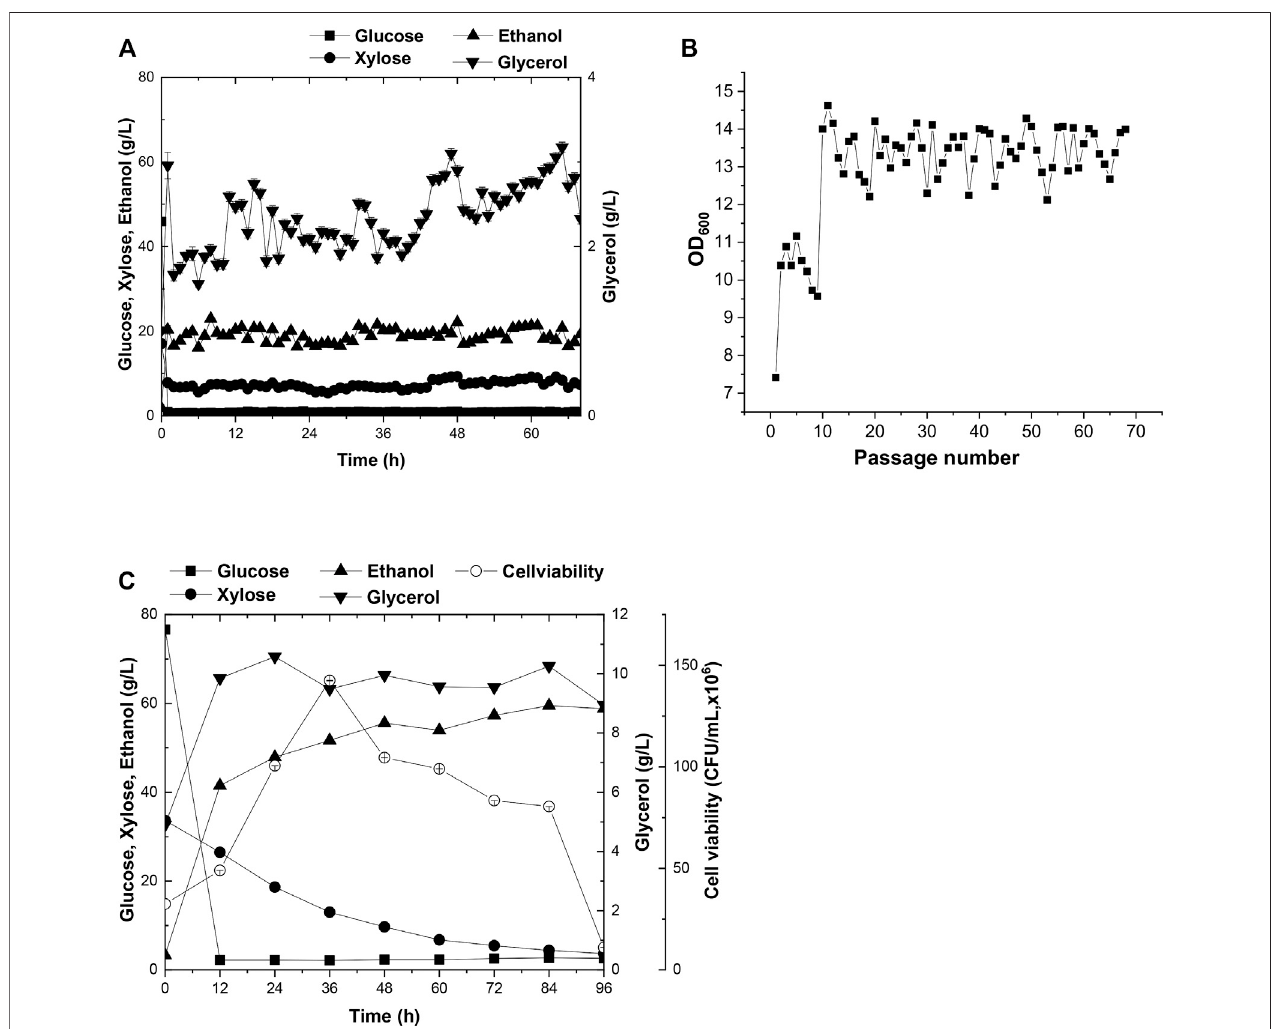
FIGURE 3 | Time-dependent fermentation of A21Z and A31Z. Fermentation pro fi le of A21Z in treated wheat straw hydrolysate with 45.85 g/L glucose, 17.07 g/L xylose, 1.84 g/L ethanol, and 1.01 g/L glycerol (A,B) . SSCF pro fi le of A31Z (C) .